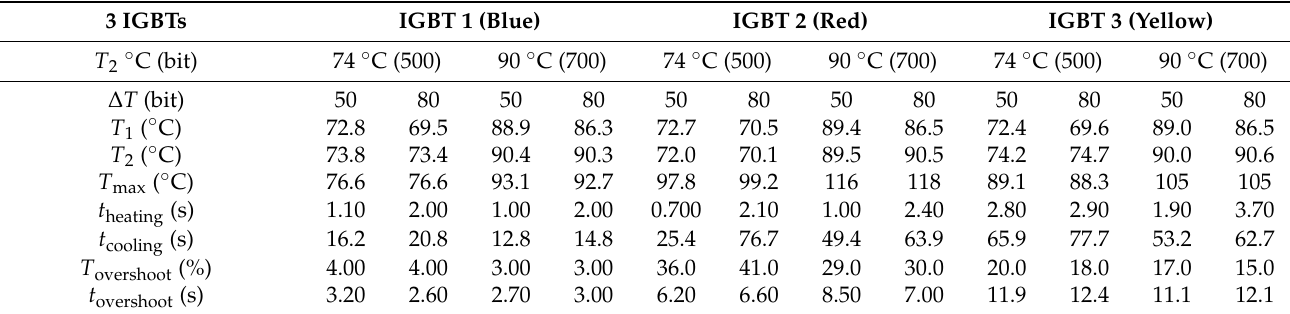
Table 5. Measurement results of Nsim algorithm for three